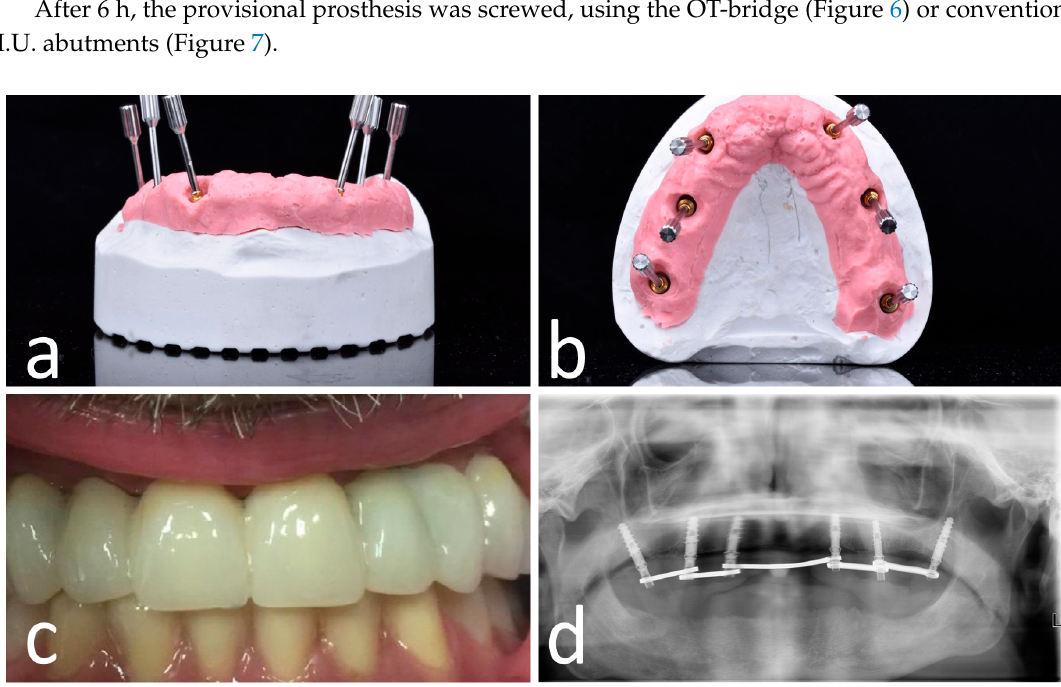
Figure 6. OT-bridge abutments use the “Extragrade ™ ” feature, a system allowing to compensate up to 80° of the divergence between two implants ( a , b ). Pictures c and d show the clinical ( c ) and X-ray ( d ) view of the provisional prosthesis using OT-bridge abutments.